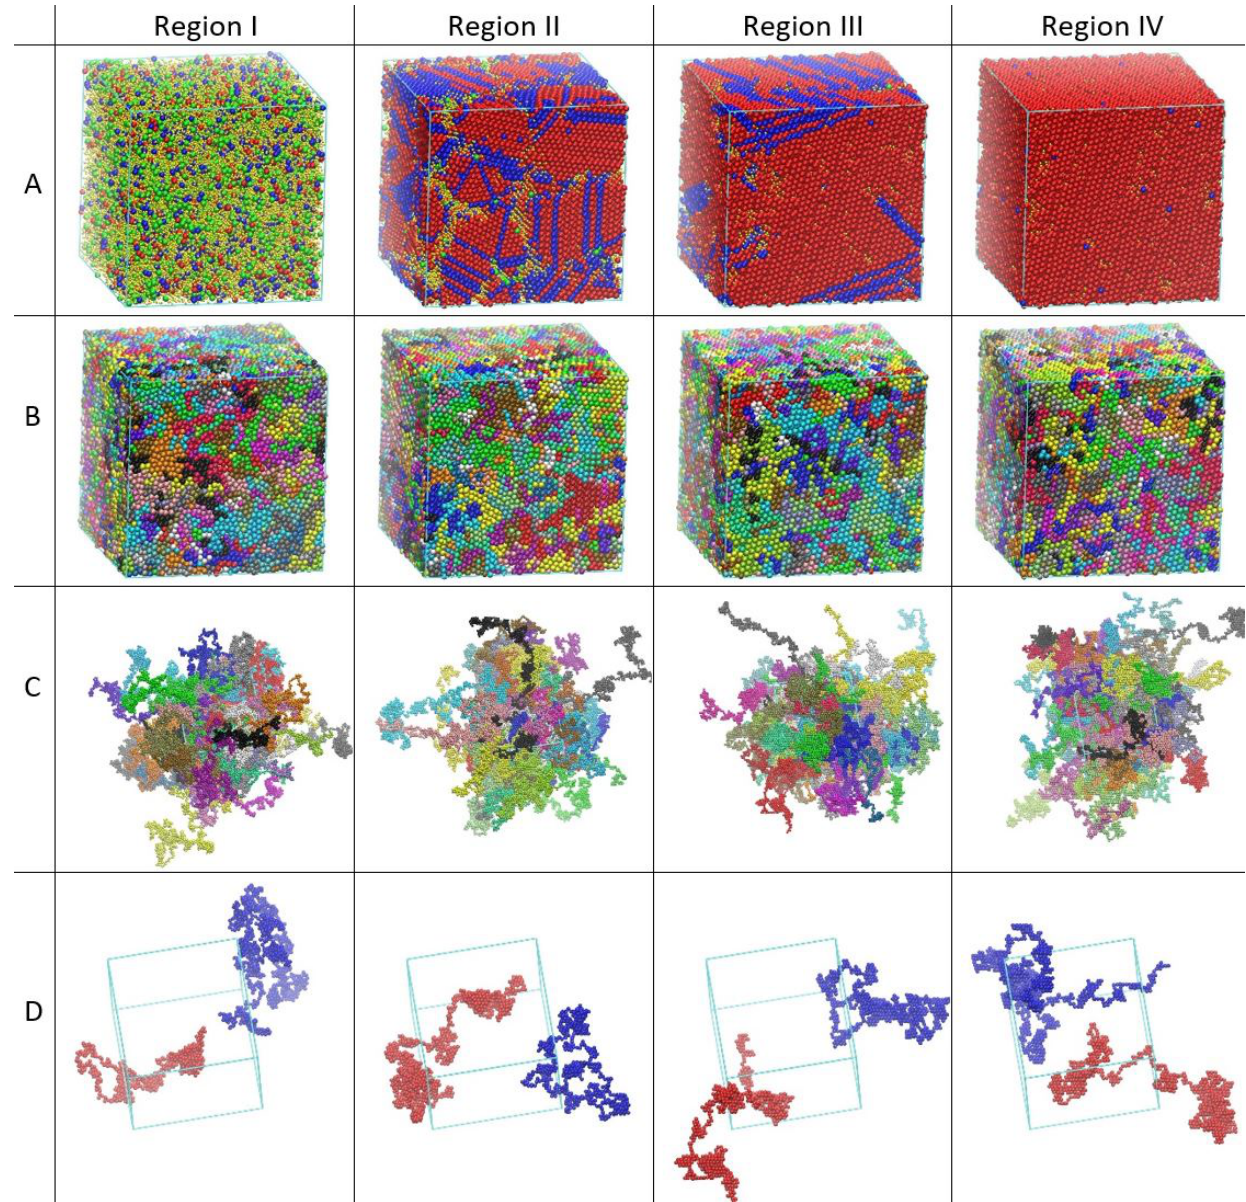
Figure 1. System snapshots along the MC simulation. From left to right: 1 × 10 8 (Region I), 4 × 10 11 (Region II), 8 × 10 11 (Region III) and 1.4 × 10 12 (Region IV, end of simulation) MC steps. From top to bottom: ( A ) Sites are colored according to their structural similarity as quantified through the CCE norm descriptor [93] with blue, red and green corresponding to sites with HCP, FCC and FIV character, respectively. Amorphous (AMO) sites are shown in yellow and with reduced dimensions for visual clarity. The stable FCC crystal (fourth, rightmost snapshot) is obtained in the steady state (up to fluctuations) MC production phase, after approximately 9 × 10 12 MC steps; ( B ) Sites are colored according to their parent chain and are shown with wrapped coordinates, subjected to periodic boundary conditions; ( C ) Sites are colored according to their parent chain and are shown with coordinates fully unwrapped in space; ( D ) Two randomly selected chains are shown in red and blue with sphere coordinates fully unwrapped in space. Image panels created with the VMD software [95]. Details on the MC simulation and the corresponding trajectory can be found in